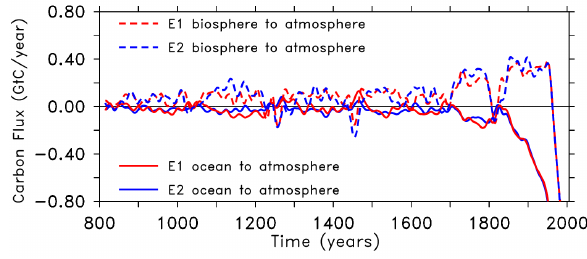
Fig. 7. Carbon fluxes (Gigatons Carbon per year) into the atmo- sphere for the ensembles E1 (red) and E2 (blue) from the ocean (solid lines) and the land biosphere (dashed